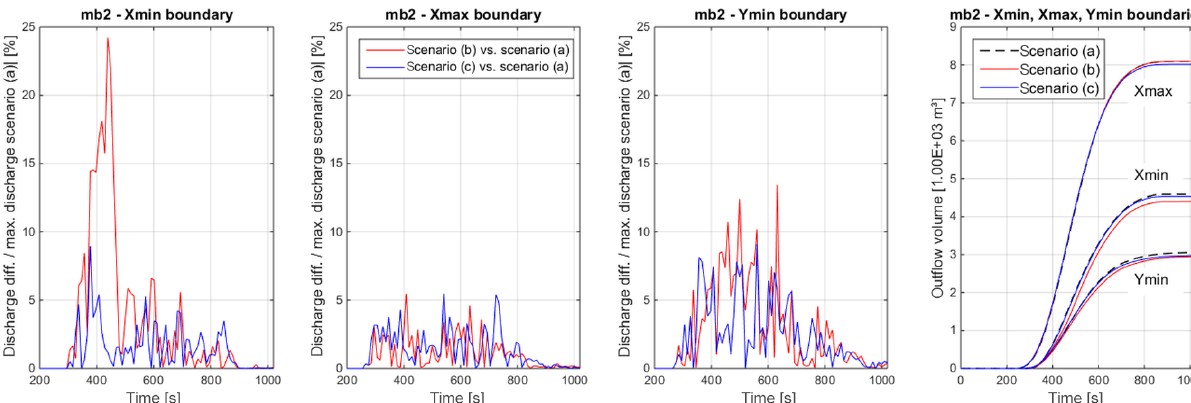
Figure 11. Discharges at the boundaries Xmin, Xmax and Ymin of mesh block mb2 (Fig. 5) – (left and middle) time-dependent discharge differences between scenario (b) and (a) in relation to the maximum discharge of scenario (a) at the considered boundaries; (right) scenario- specific outflow volumes at the